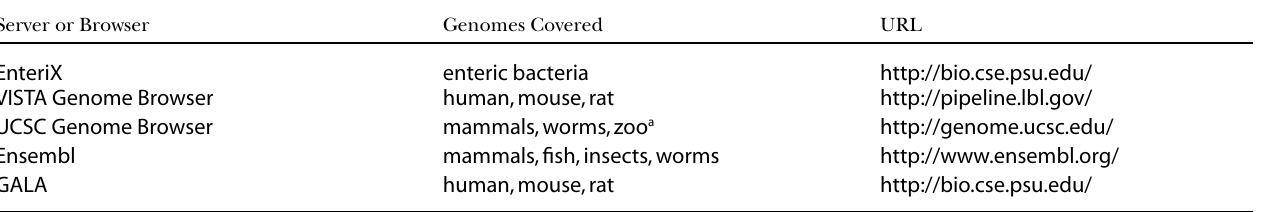
Table 1. URLs for Accessing Precomputed Whole-Genome Alignments and Their Analysis Server or Browser